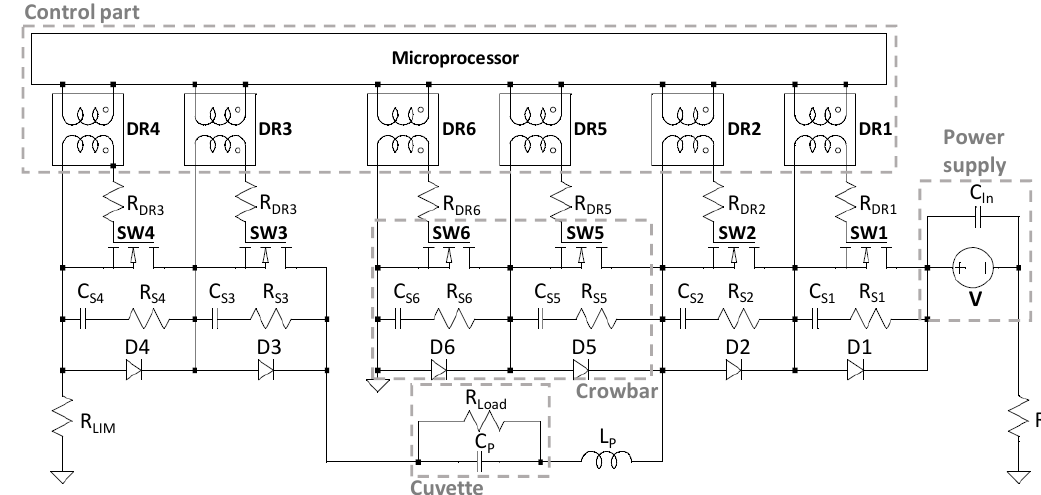
Figure 1. The simplified simulation program with integrated circuit emphasis (SPICE) pulse forming circuit for the pulsed electric field (PEF) generator.